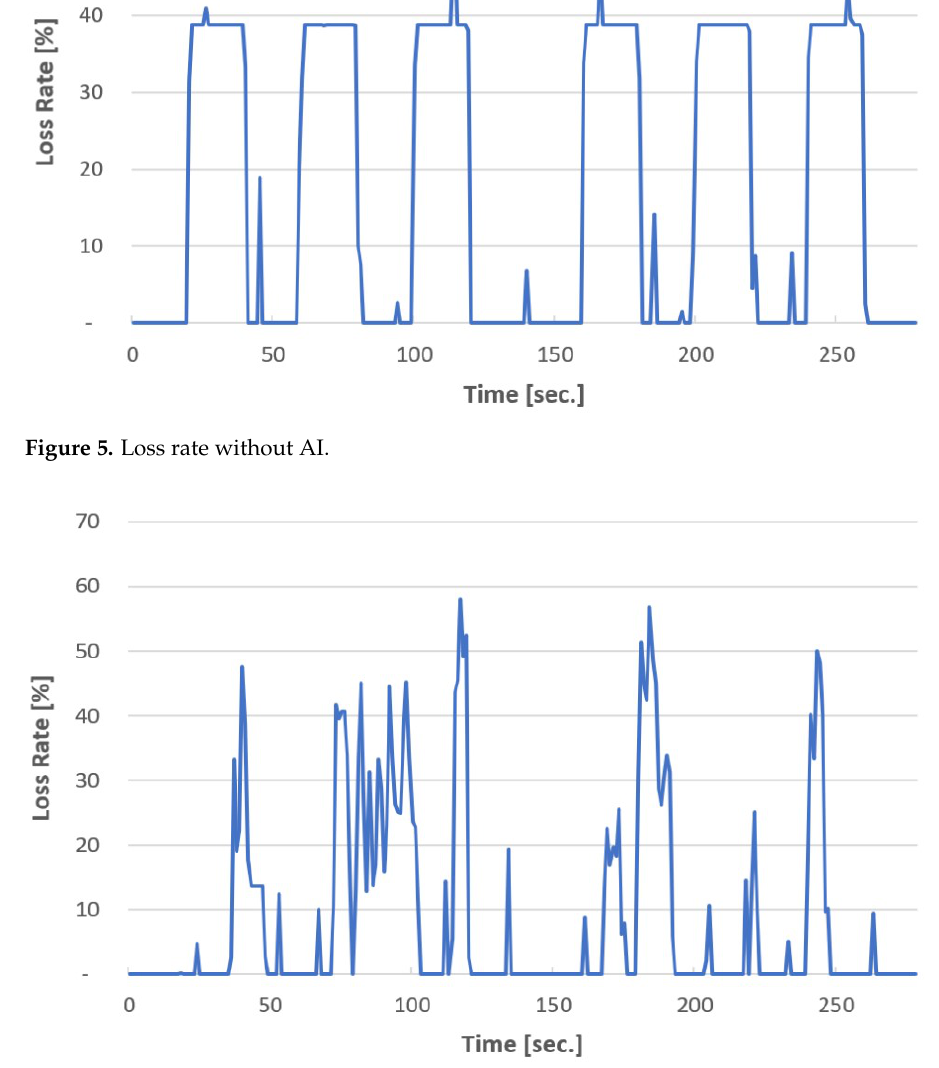
Figure 6. Loss rate with